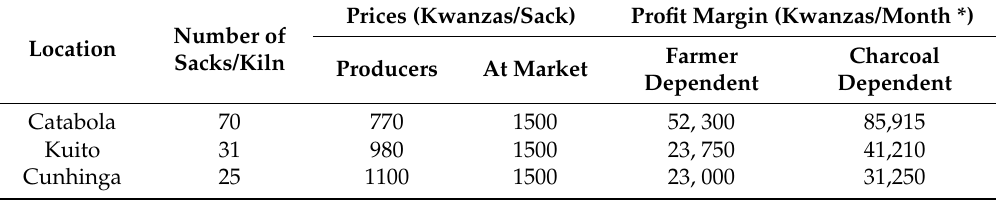
Table 2. Comparison of profit margin between farmer-dependent and charcoal-dependent